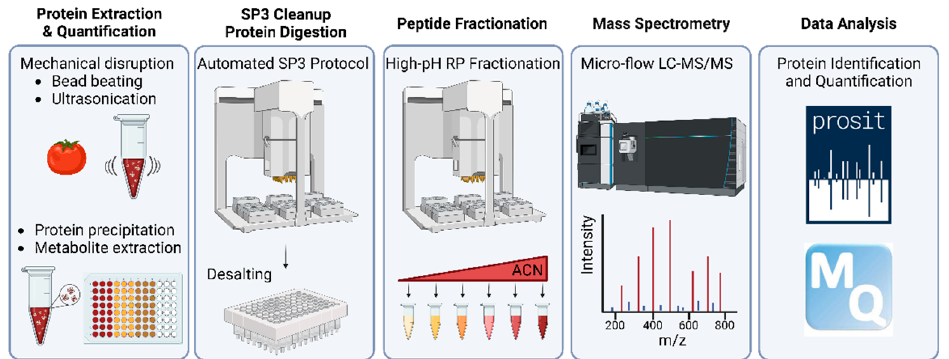
Figure 1. Schematic representation of the plant crop proteome profiling workflow developed in this study. ACN: acetonitrile.